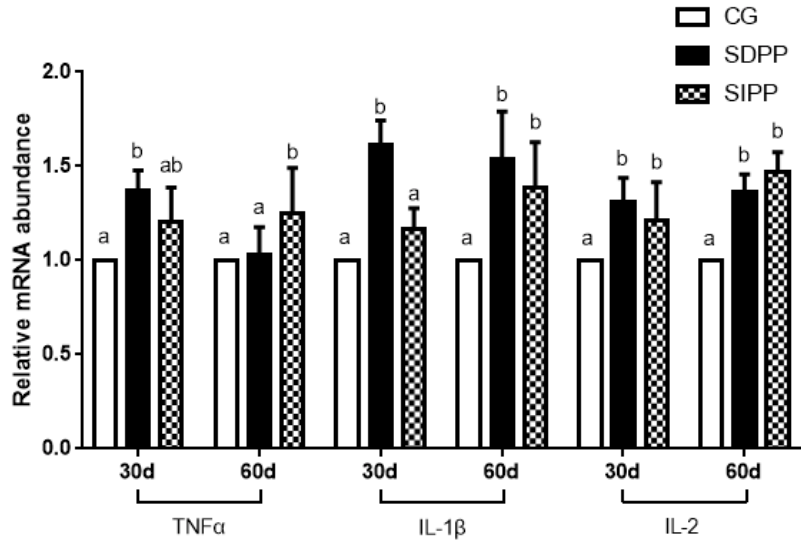
Figure 3. Effect of photoperiod change on relative gene expression of TNF2 , IL-1 β and IL-2 . Bars